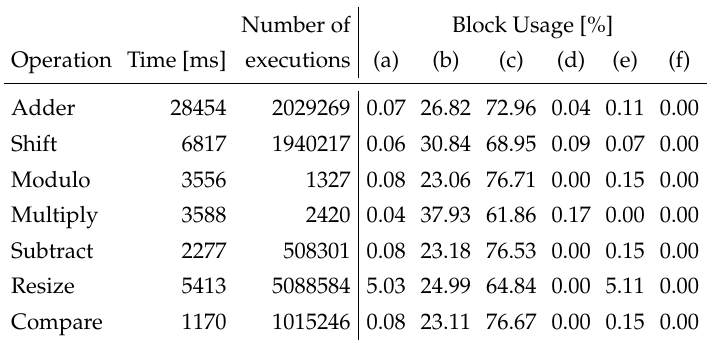
Table 2. Breakdown of the calculation duration to the individual blocks from Figure 3. As one can see, the adder consumes the most time due to the high number of